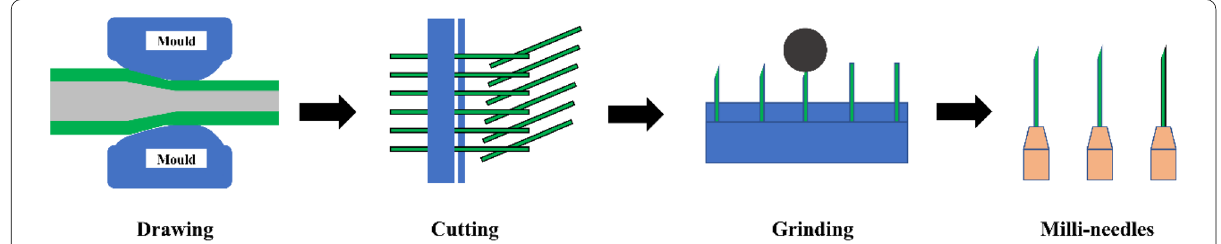
Figure 4 Fabrication process of